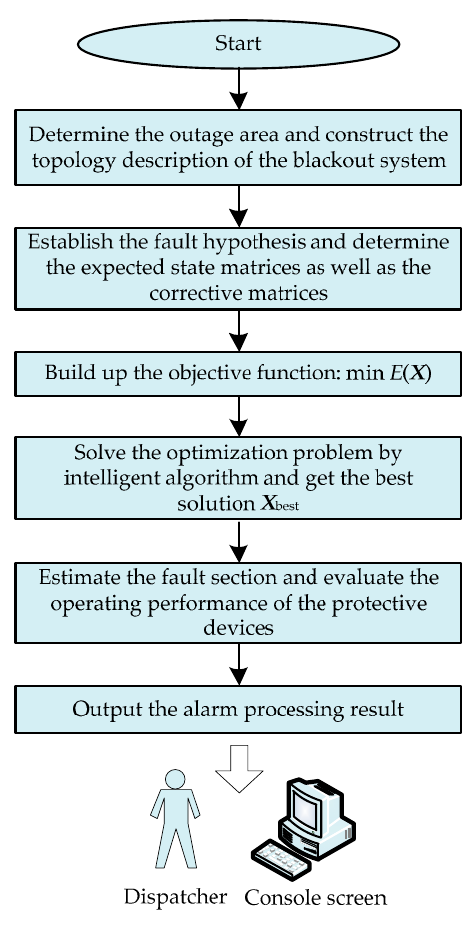
Figure 4. Framework of the fault diagnosis method.